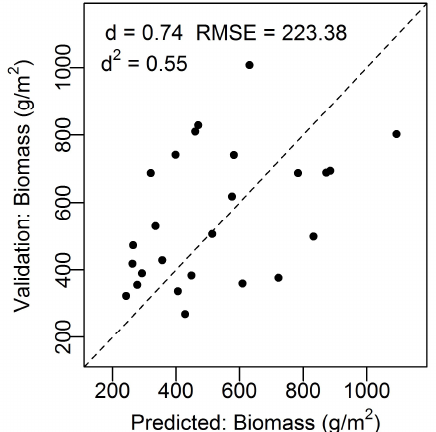
Figure 2. Modeled biomass (g/m 2 ) from the combined modified soil vegetation index 2 (MSAVI 2 ) and visible difference vegetation index (VDVI) versus the validation biomass (g/m 2 ) data. Dashed line corresponds to the 1:1 line indicating a perfect match between the measured and predicted values. Root mean square error (RMSE) = 223.38 g/m 2 , Willmott’s index of agreement (d) = 0.74, and squared